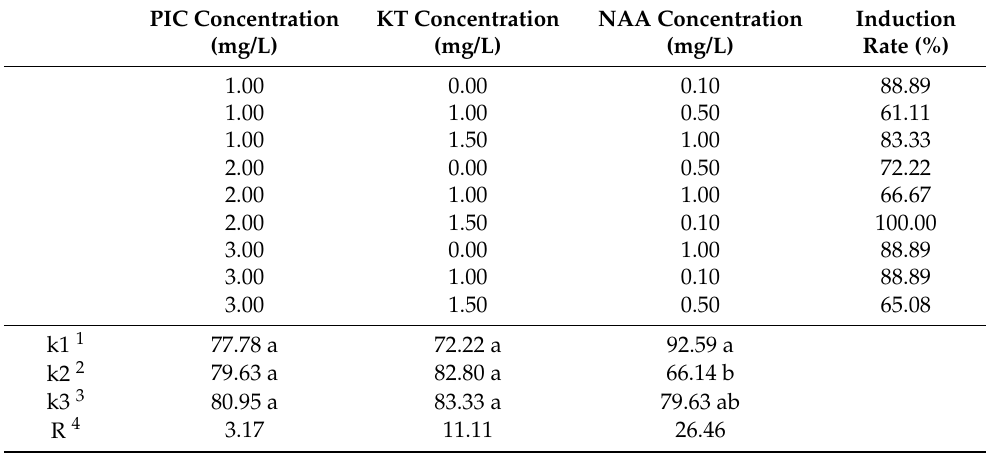
Table 3. Effects of combination of PIC, NAA and KT on callus induction from A. praecox root